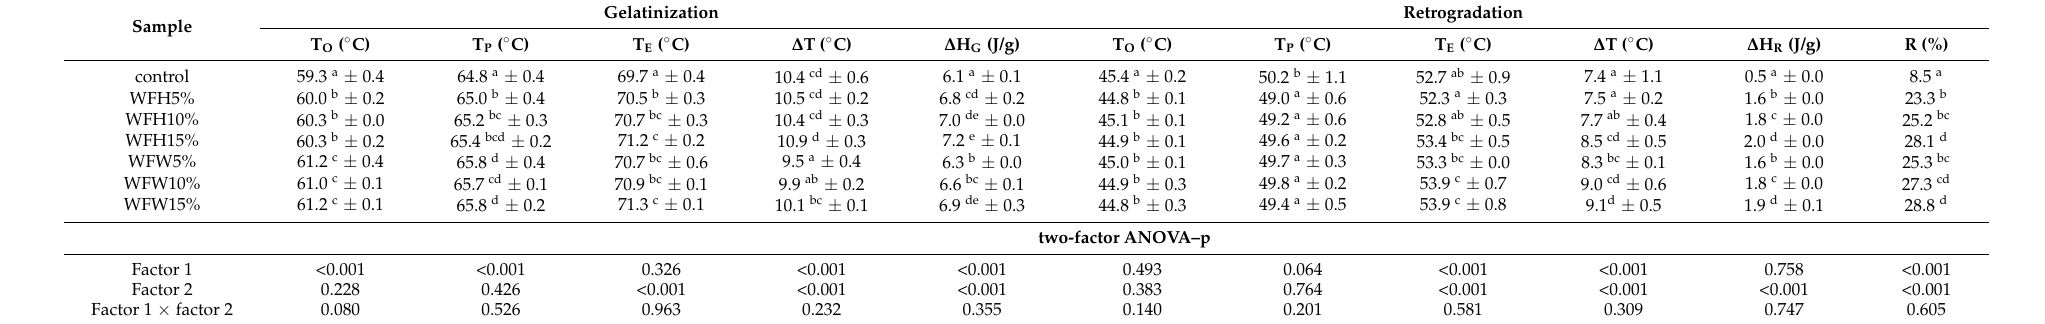
Table 1. Thermodynamic characteristics of gelatinization and retrogradation of systems wheat flour with